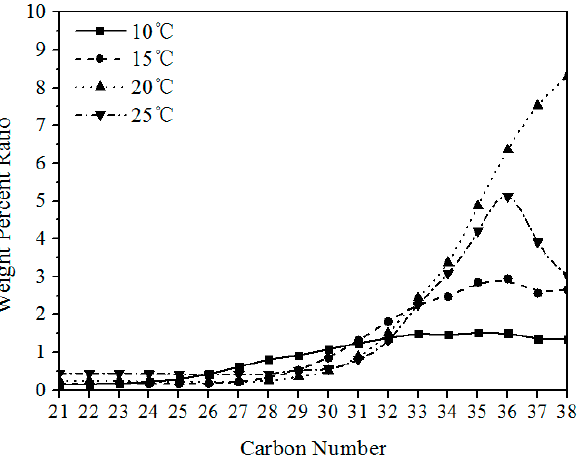
Figure 11. The weight percent ratio of each carbon number in precipitated wax at different temperatures of 10% artificial oil.